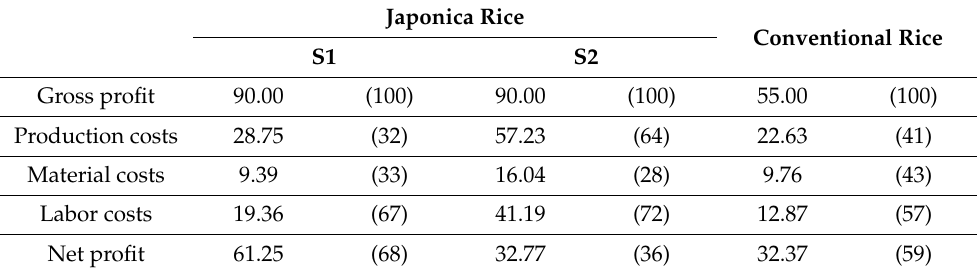
Table 2. Comparison of production costs between japonica rice and conventional rice (unit: